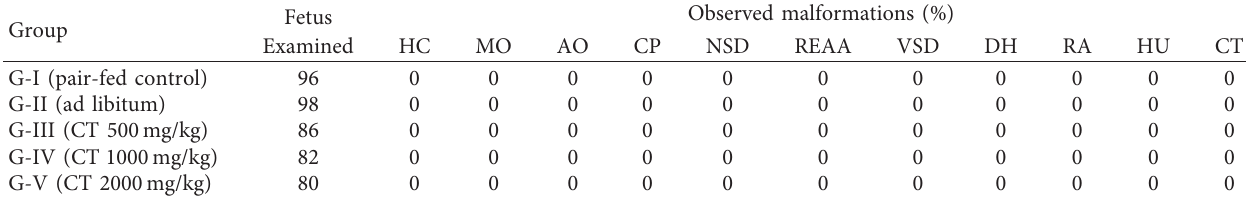
Table 8: Visceral malformations of rat fetuses after administration of the essential oil of Thymus schimperi . Fetus Group